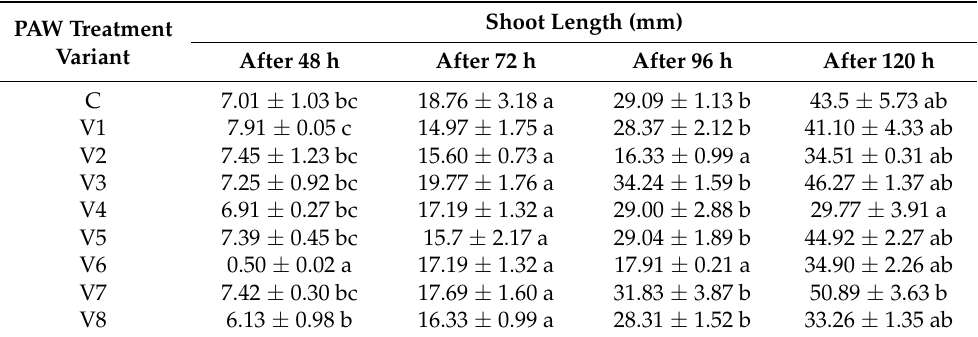
Table 6. Dynamics of wheat shoot length growth under the influence of non-thermal plasma-activated water treatments. Shoot Length (mm) PAW Treatment Variant After 48 h After 72 h After 96 h After 120